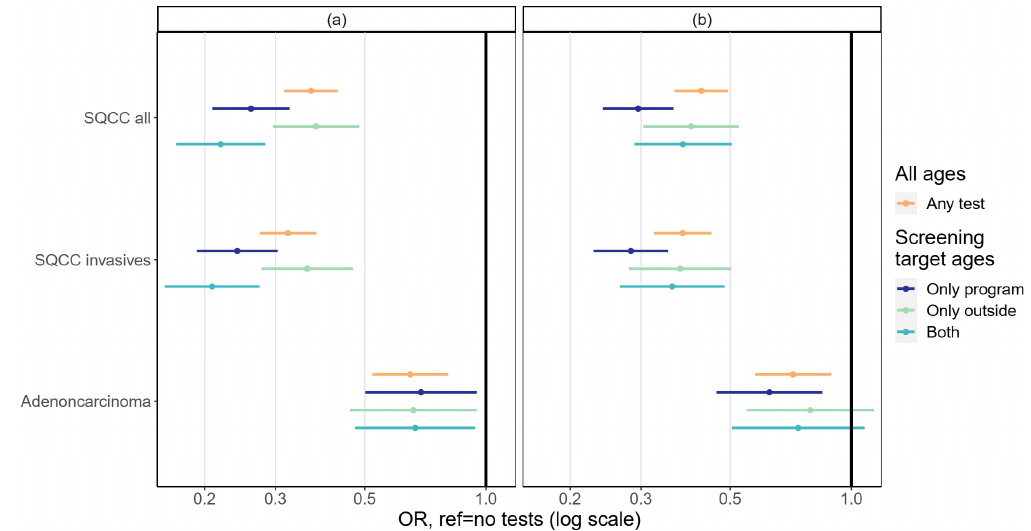
Figure 3. Association between testing in ( a ) a five-year interval and ( b ) a three-year interval and cervical cancer diagnosis at the following five-year interval by morphology. Adjusted for education, socioeconomic status, and mother tongue. SQCC = squamous cell carcinoma.